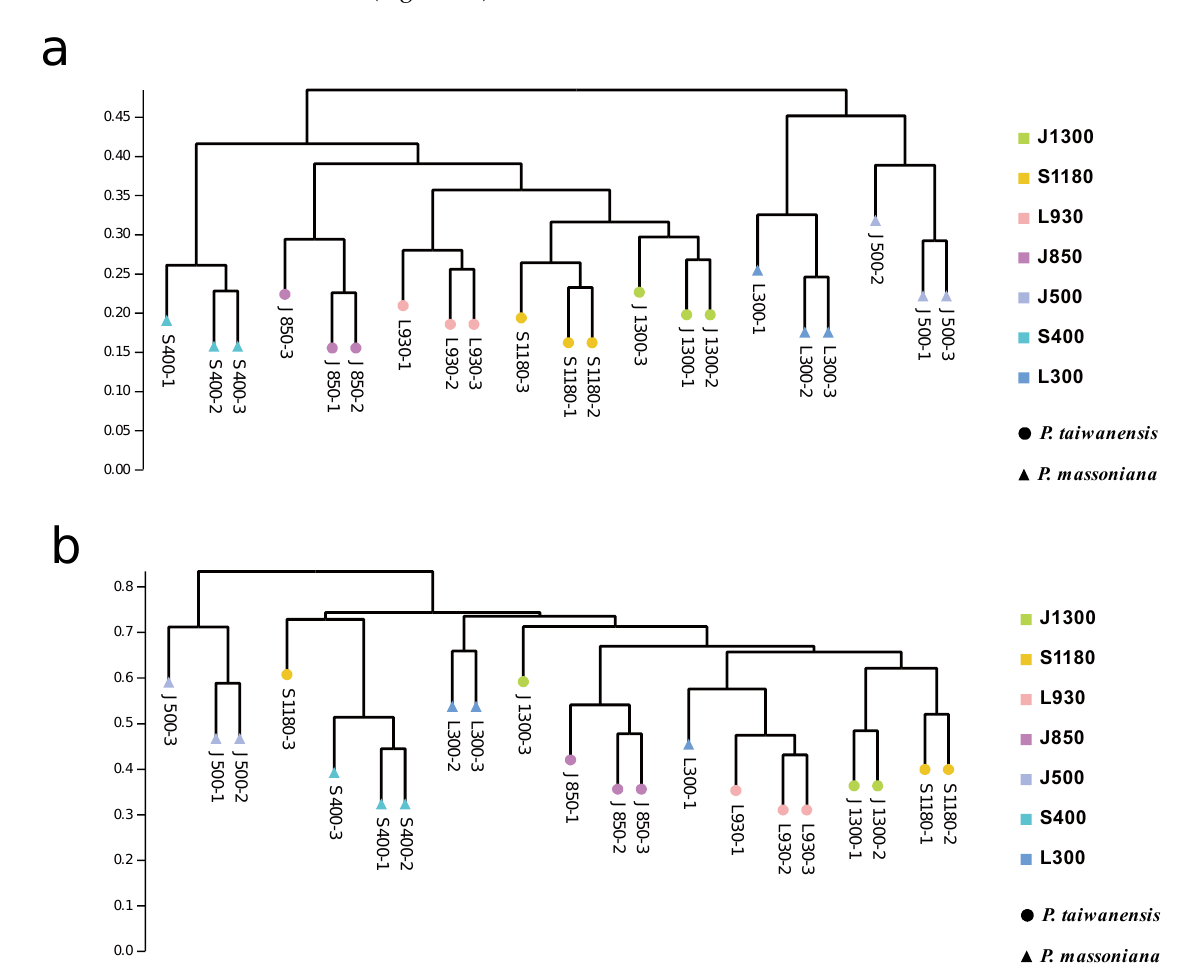
Figure 3. UPGMA cluster tree of bacterial ( a ) and fungal ( b ) communities in different forest soils at different elevations.